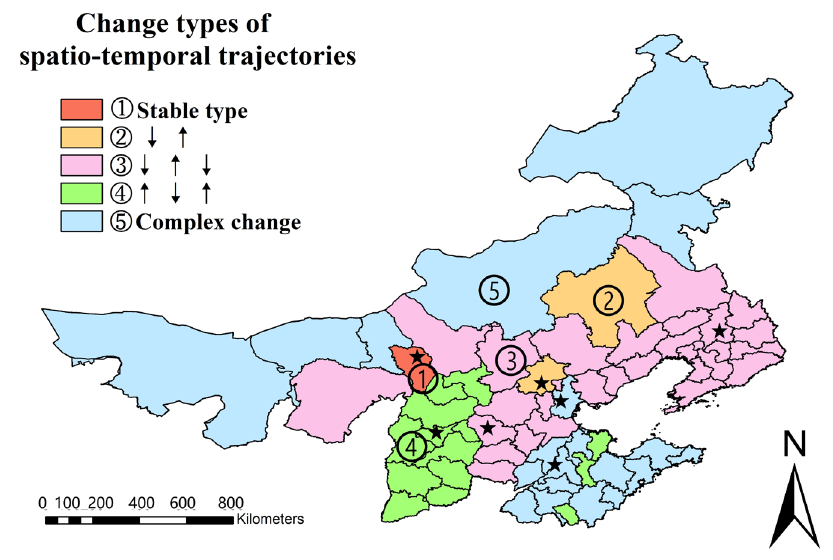
Figure 10. Psychological tolerance index types with spatial and temporal variation. (The stars indicate the capitals of seven provinces).